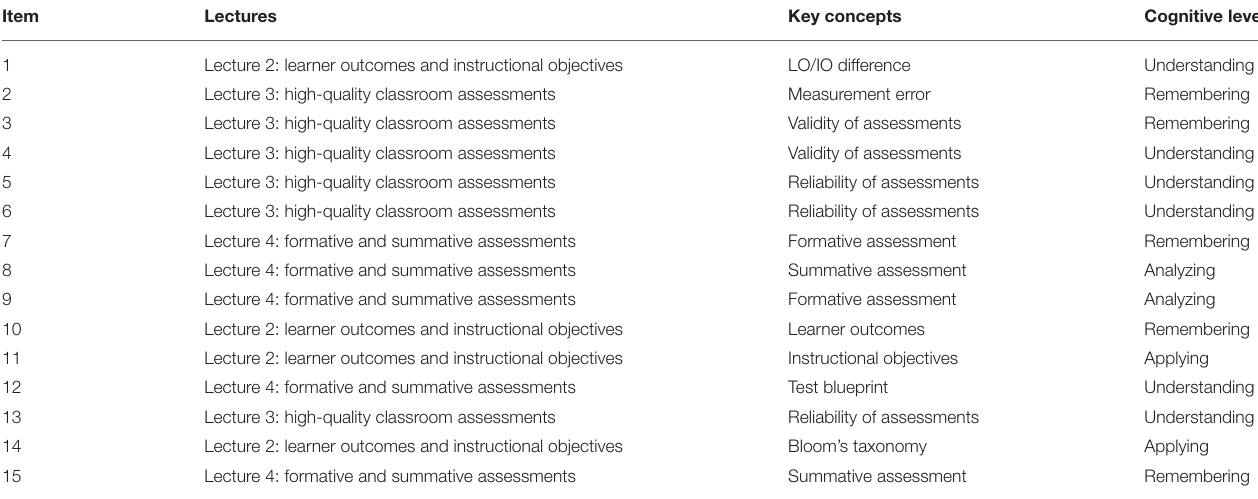
TABLE 1 | A sample test blueprint used for generating score reports from Examvis.